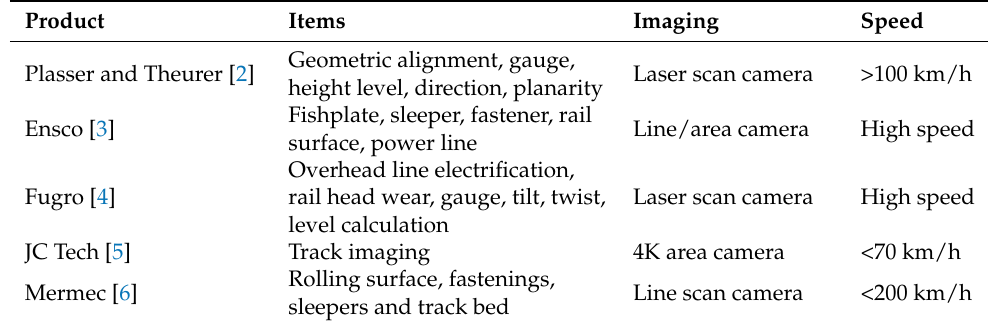
Table 1. Some commercial track inspection